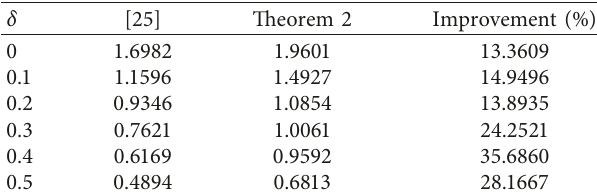
M for different δ ’s.